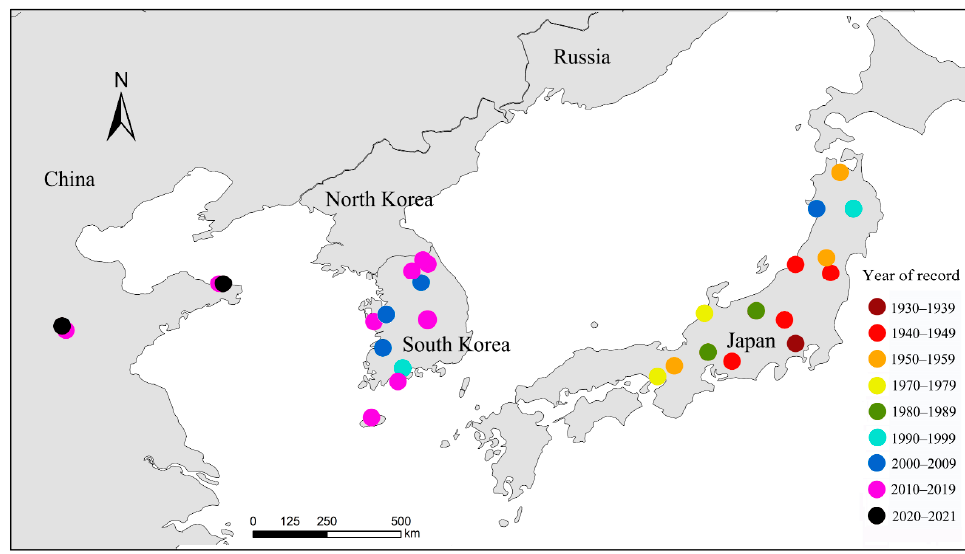
Figure 1. Invasion track of Hylurgus ligniperda in East Asia. Park et al. [11] first recorded Hylurgus ligniperda in Korea based on deposited